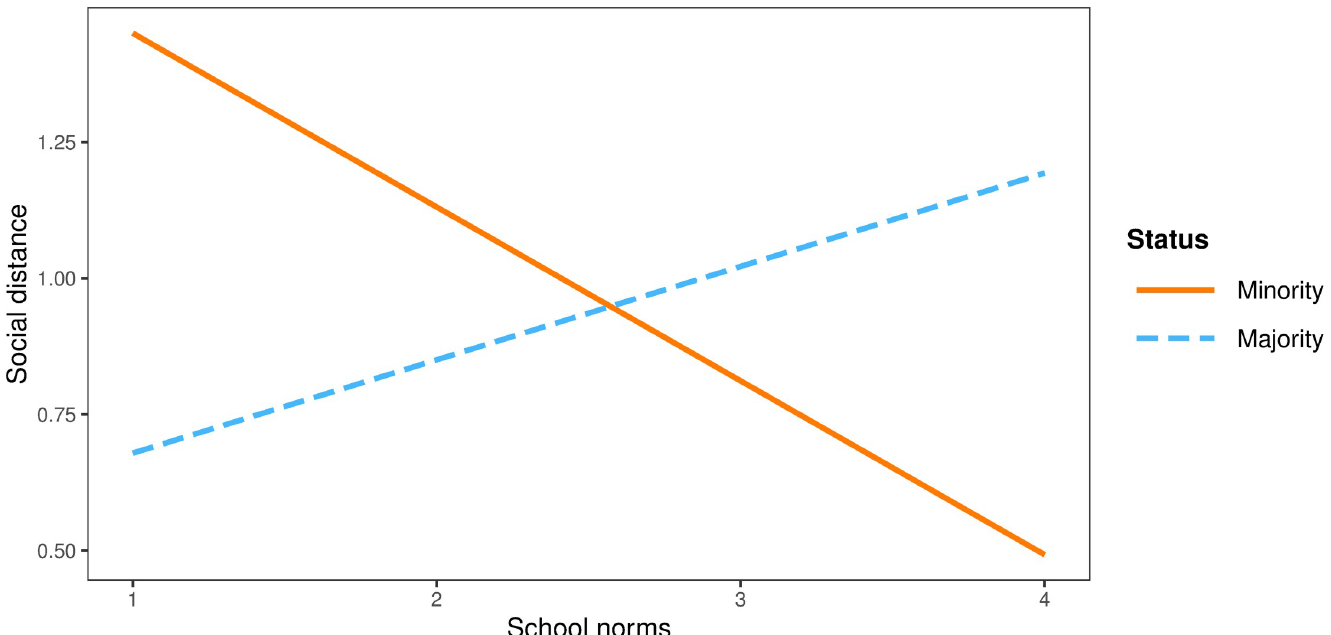
Fig 6. Interaction plot between school norms and group status on social